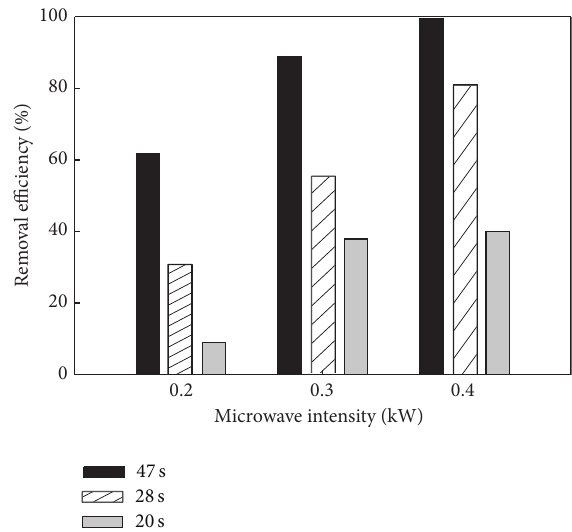
Figure 6: Effect of reaction residence time on photocatalytic removal efficiency of HCFC-22.